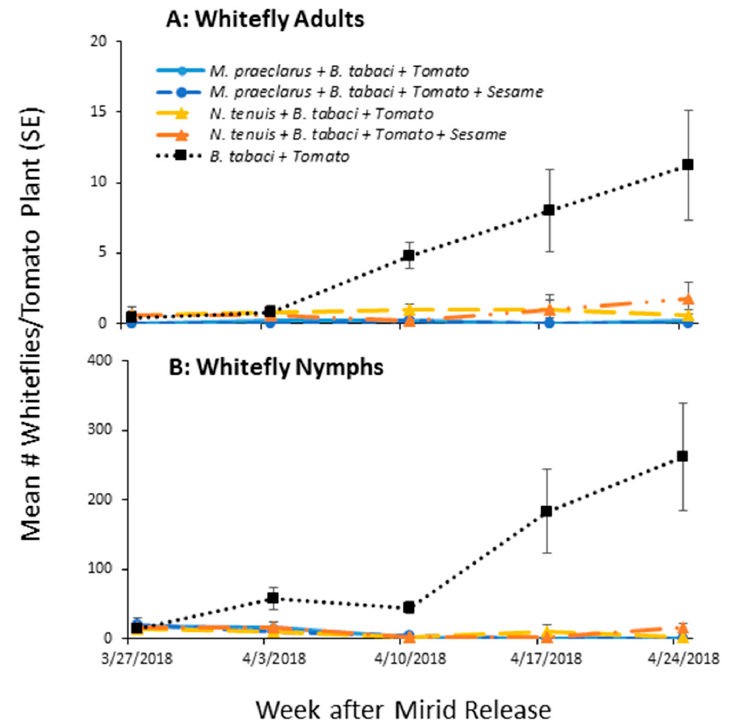
Figure 5. Mean (±SE) number of adult ( A ) and nymph ( B ) whiteflies ( Bemisia tabaci ) found on tomato plants with no predators ( B. tabaci + Tomato), on whitefly infested tomato plants with Macrolophus praeclarus in cages with only tomato plants ( Macrolophus praeclarus + Whiteflies + Tomato) or 5 tomato plants with one sesame plant added ( M. praeclarus + Whiteflies + Tomato + Sesame) and on prey infested tomato plants with Nesidiocoris tenuis in cages with only tomato plants ( N. tenuis + Whiteflies + Tomato) or 5 tomato plants with one sesame plant added ( N. tenuis + Whiteflies + Tomato + Sesame) over a five week field cage study.